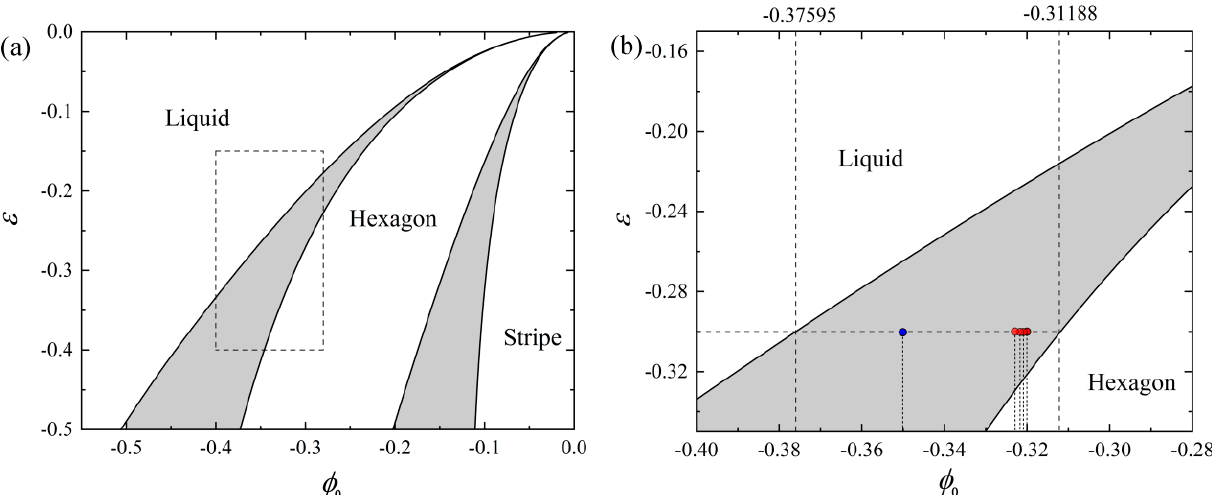
Figure 1. ( a ) The two-dimensional phase diagram of the PFC model derived from Equation (3), where the gray parts are coexistence regions of two adjacent phases; ( b ) the amplified image corresponds to the dashed box area marked in ( a ), and the blue and red dots represent the used parameters.